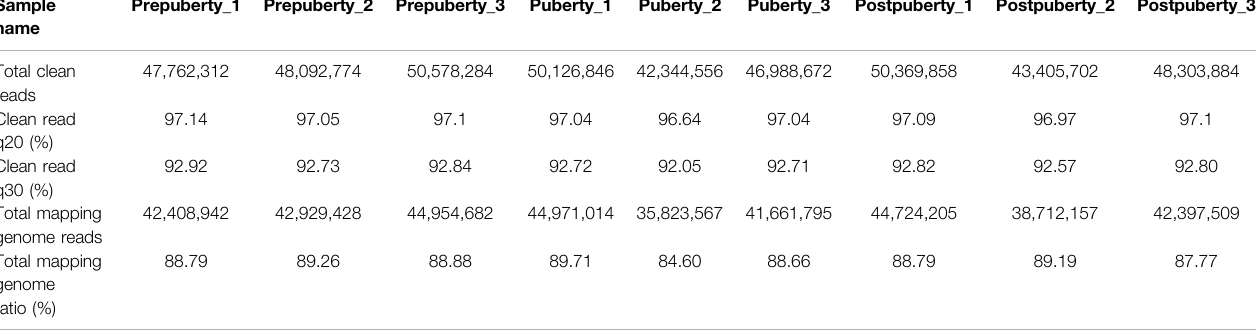
TABLE 1 | Summary of read numbers of in the prepuberty, puberty, and postpuberty groups.